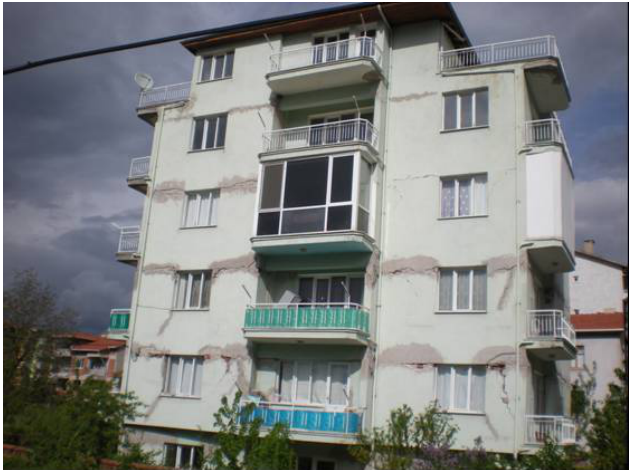
Figure 17. Building damaged during the 2009 and 2011